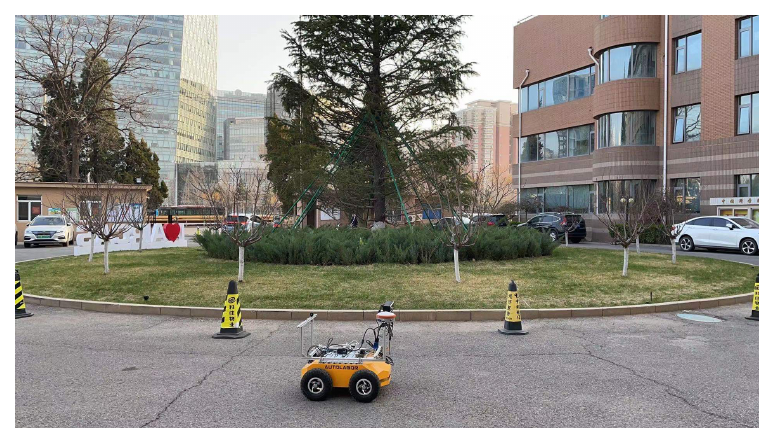
Figure 9. The experiment environment.